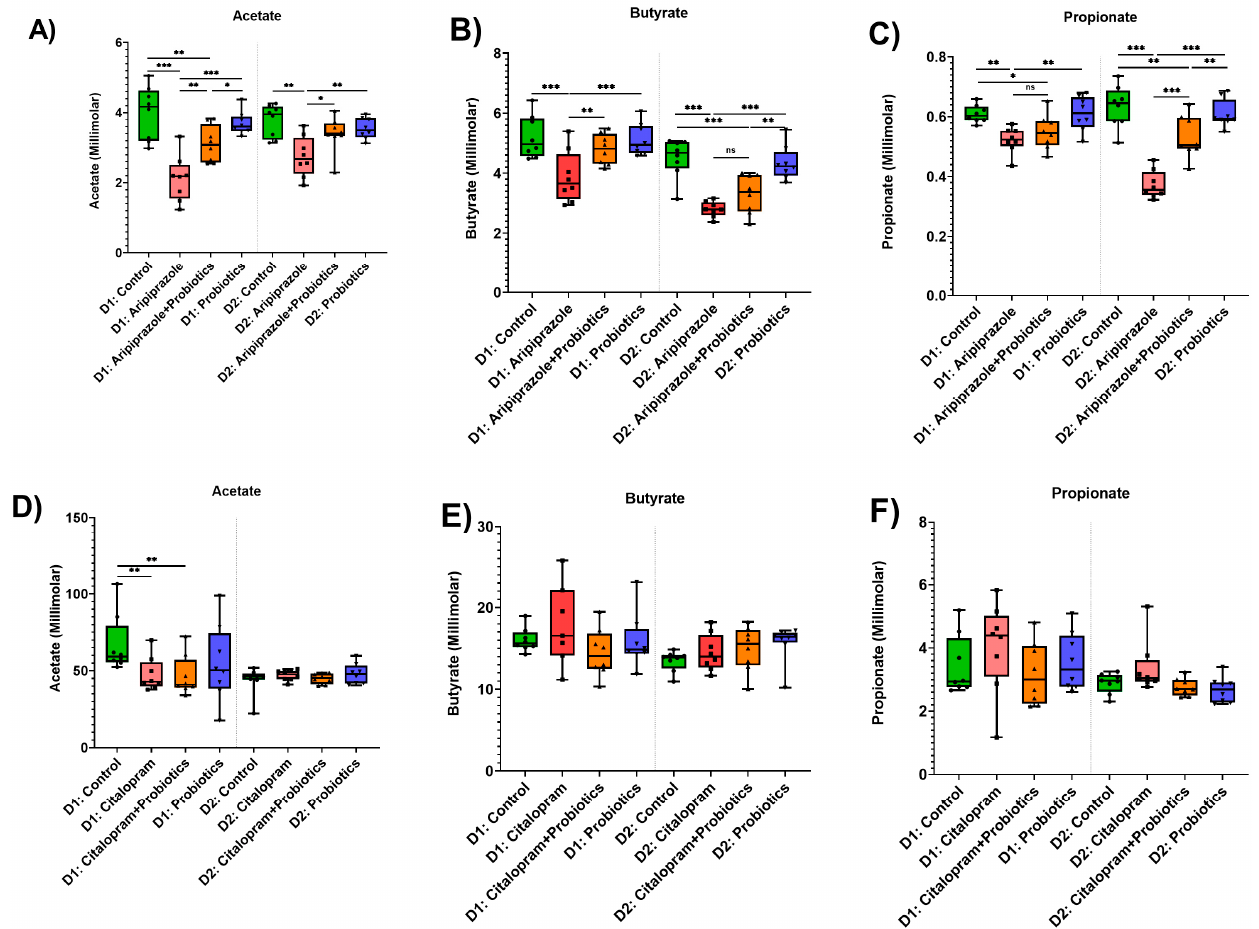
Figure 6. Short-chain fatty acids (SCFAs) concentration was measured by GC over 48 h with all treatment groups with aripiprazole ( A – C ) or Citalopram ( D – F ). ( A , D ) acetate, ( B , E ) butyrate,